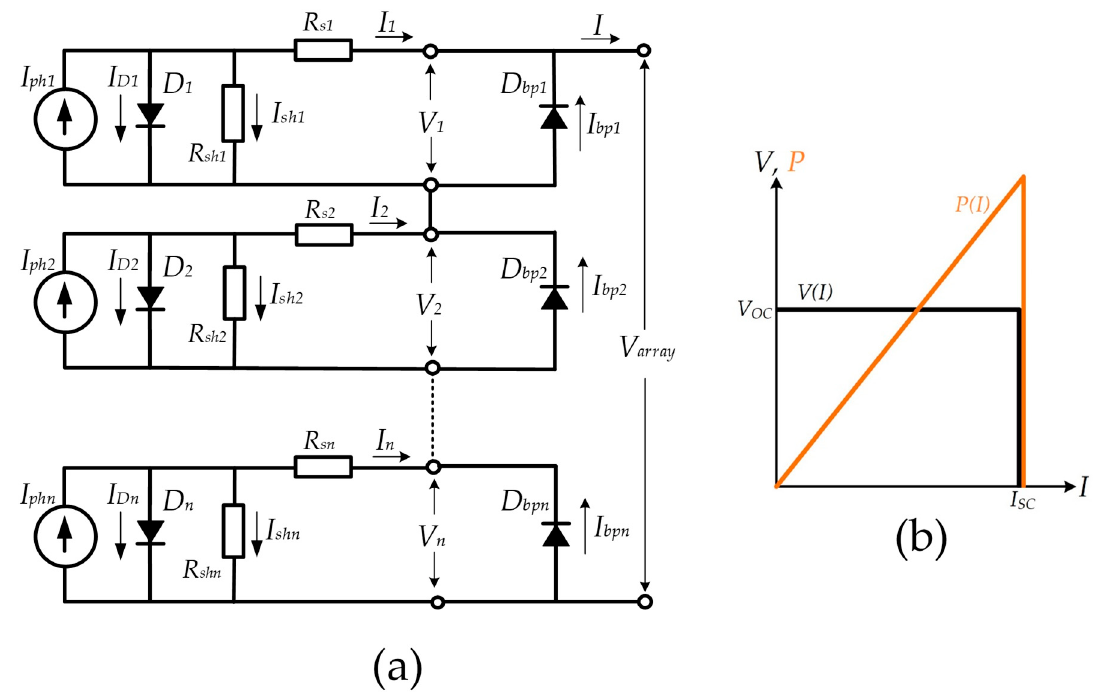
Figure 3. ( a ) The equivalent circuit of a solar array including n -individual solar modules with parallel bypass diodes ( I ph1 , I ph2 , I phn are photocurrents of PV modules; I D1 , I D2 , I Dn are currents through diodes; R sh is shunt resistance, I sh1 , I sh2 , I shn are shunt currents; R S1 , R S2 , R Sn are series resistance; D bp1 , D bp2 , D bpn are bypass diodes attached to each PV module; I bp1 , I bp2 , I bpn are currents through bypass diodes; V 1 , V 2 , V n are output voltages PV modules; I 1 , I 2 , I n are output currents of PV modules; I and V array are the current and voltage of n -serially connected in PV modules array), ( b ) The V–I and P–I characteristic corresponds to the simplified equivalent circuit of the n -serially connected solar modules array ( V OC is open-circuit voltage and I SC is short circuit current).